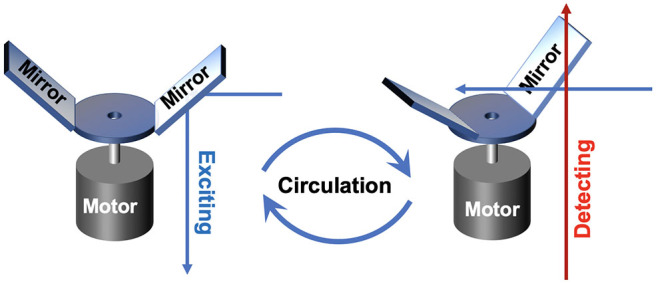
Schematics of gated autosynchronous luminescence detection with the special designed chopper in excitation and detection process.